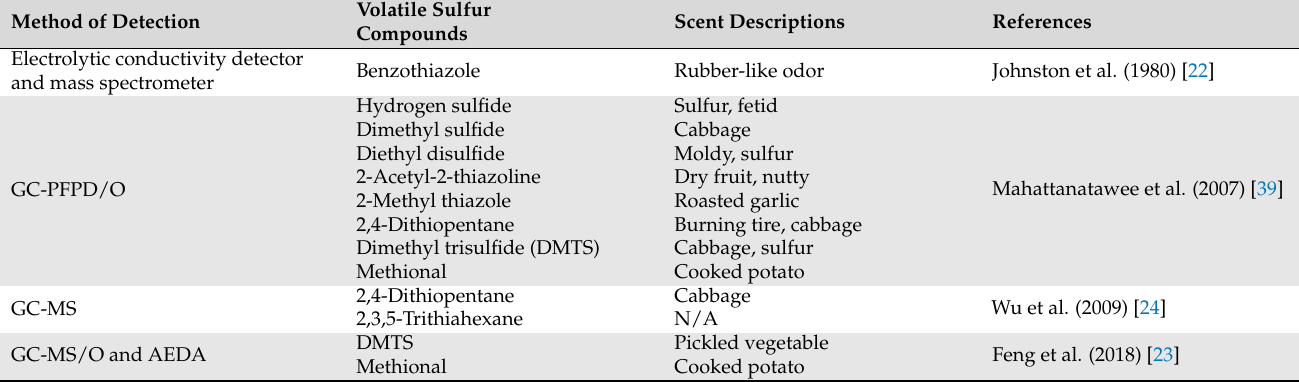
Table 3. List of VSCs found in litchi fruit and their aroma